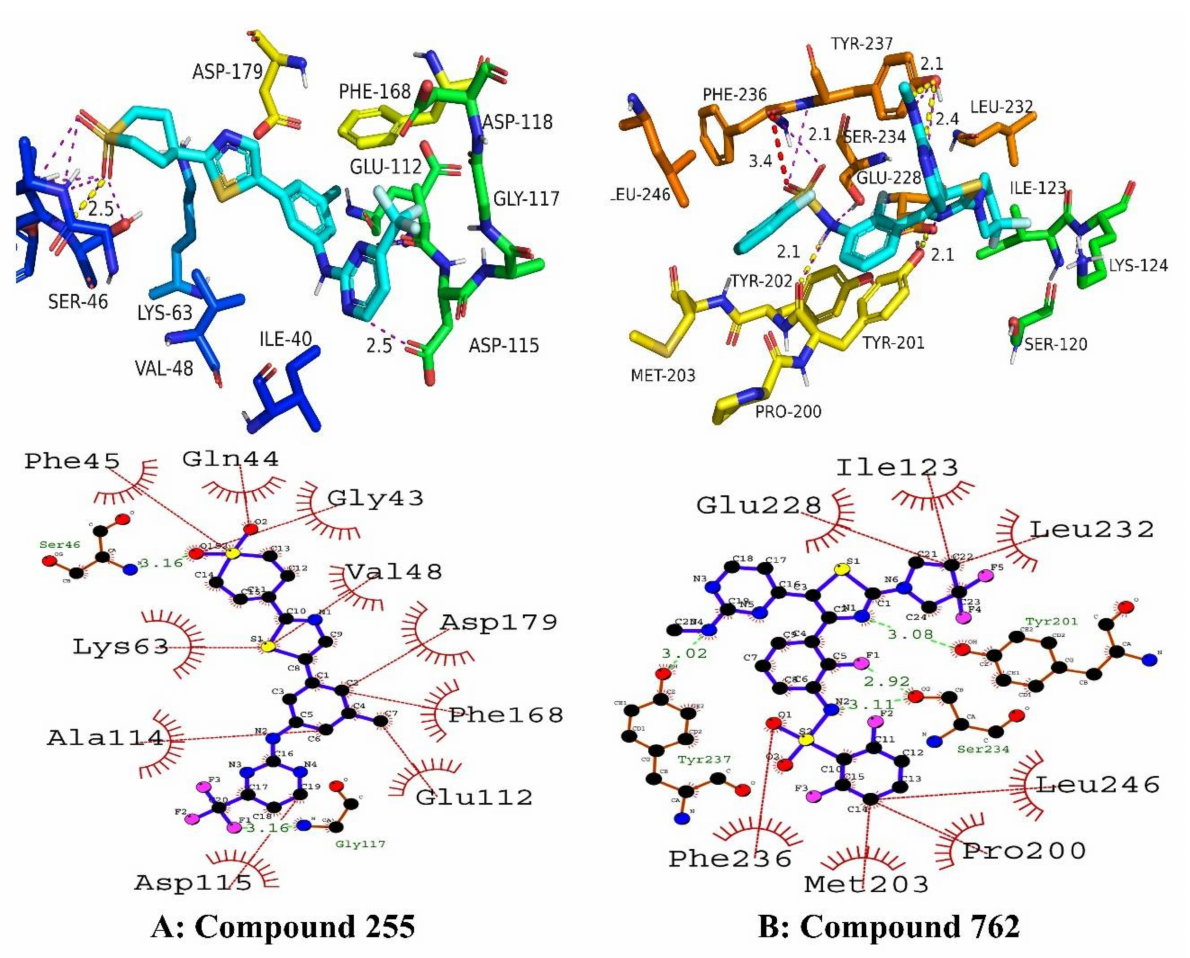
Figure 6. The putative 2D and 3D binding mode of compound 255 ( A ) and 762 ( B ). Green dashes are indicating hydrogen bonding whereas red dashes are indicating hydrophobic